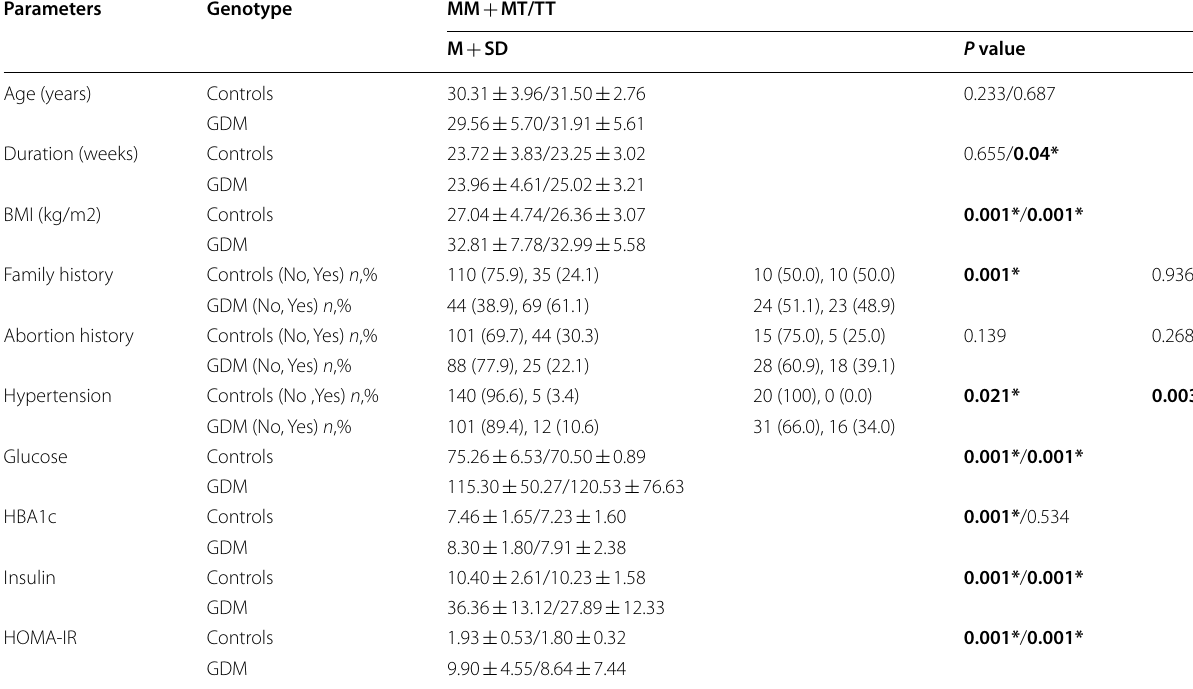
Table 3 Relation between various genotypes of the AGT (M/T) and risk factors among GDM and